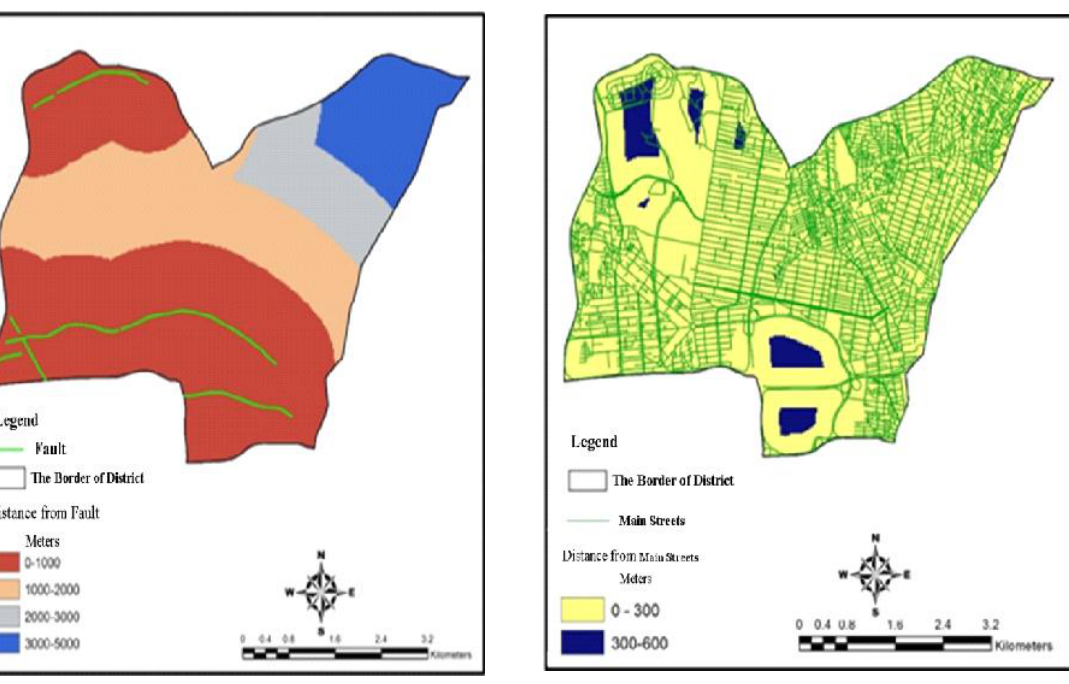
Fig. 8: The distance from main streets